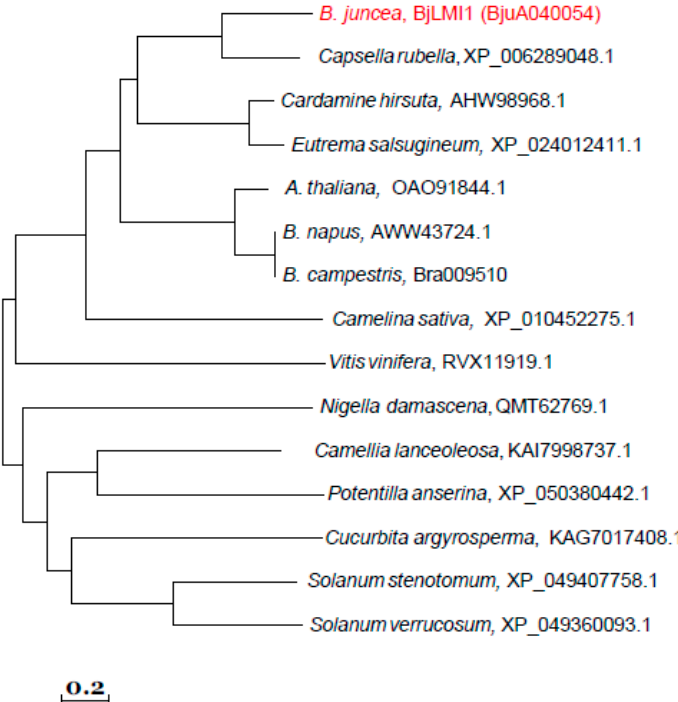
Figure 3. Phylogenetic relationships among ATHB proteins from different plant species. Phylogenetic tree inferred using the NJ method. Numbers indicate the percentage of replicate trees in which the associated taxa clustered together in the bootstrap test (1000 replicates). The tree is drawn to scale, and branch lengths indicate evolutionary distance. Evolutionary analyses were conducted in MEGA-X.